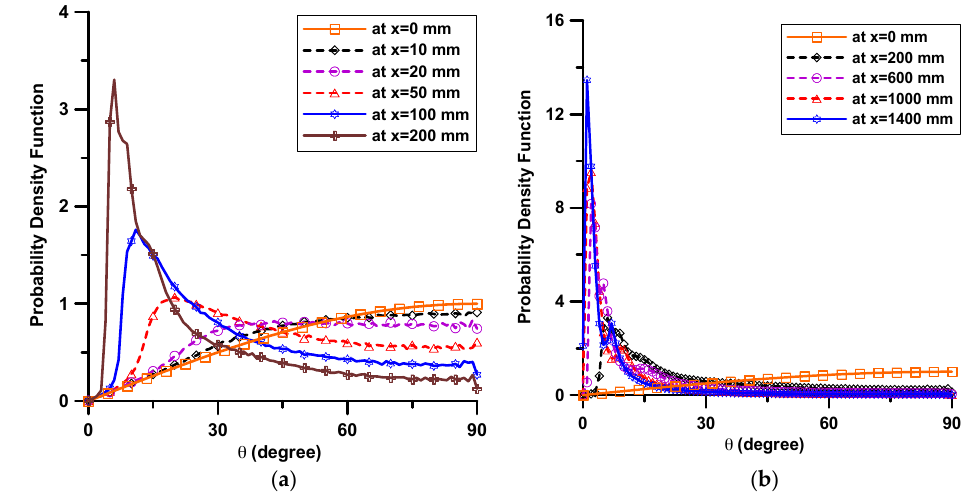
Figure 3. Probability density functions of θ according to the flow distance; ( a ) up to 200 mm flow distance; and ( b ) for overall flow distance.